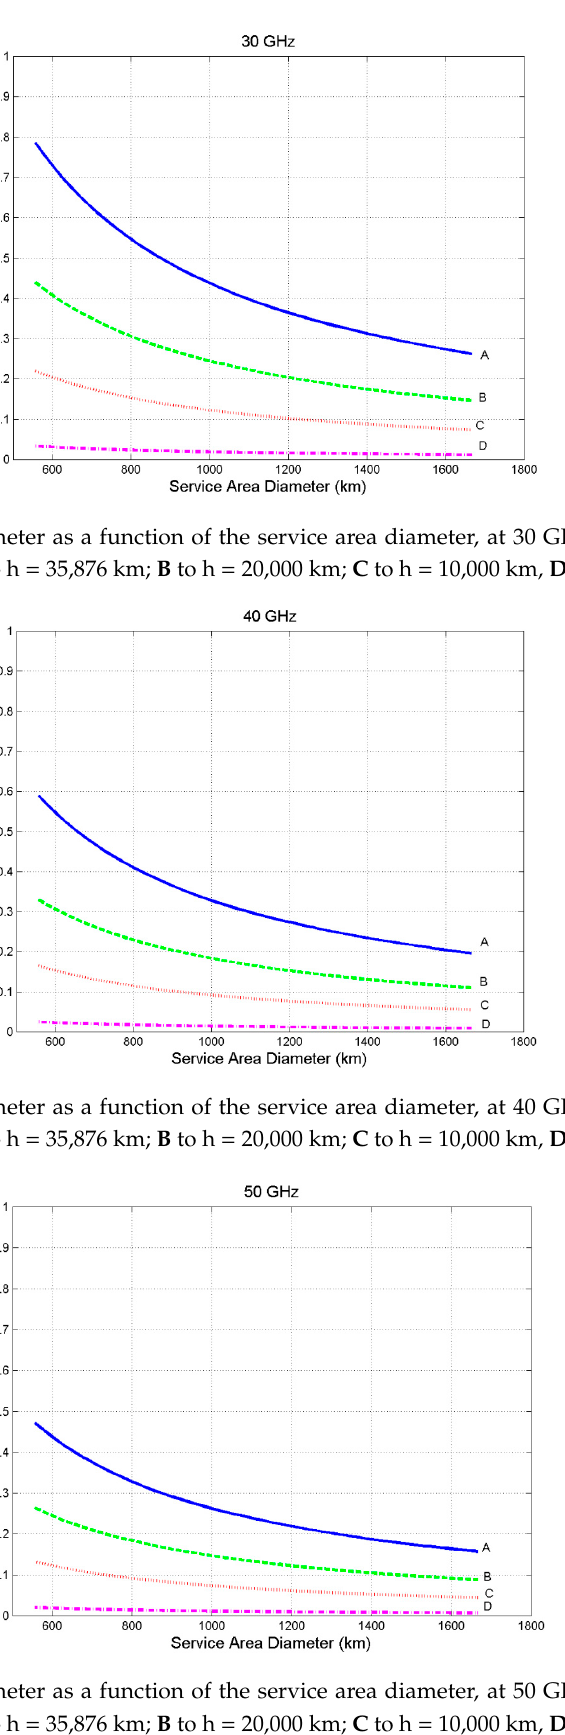
Figure 6. Antenna diameter as a function of the service area diameter, at 20 GHz for the GeoSurf constellation. A refers to ℎ = 35,876 km; B to ℎ = 20,000 km; C to ℎ = 10,000 km, D to ℎ = 1500 km.